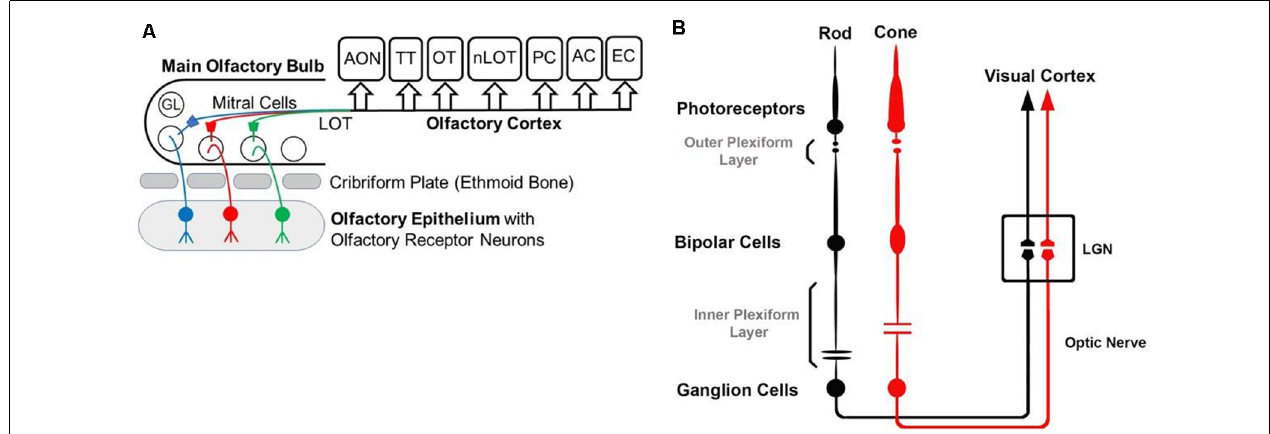
FIGURE 1 | Diagrams of the olfactory (A) and visual (B) pathway. (A) GL—glomerulus, LOT—lateral olfactory tract, AON—anterior olfactory nucleus, OT—olfactory tubercle, PC—piriform cortex, EC—entorhinal cortex, AC—amygdaloid complex, TT—tenia tecta, nLOT—nucleus of Lateral Olfactory Tract. (B) Simplified visual pathway of light responses through photoreceptors, bipolar cells, and ganglion cells and on to lateral geniculate nucleus (LGN) in the thalamus. Retinal horizontal and amacrine cells are omitted to highlight the pathway of the light response.